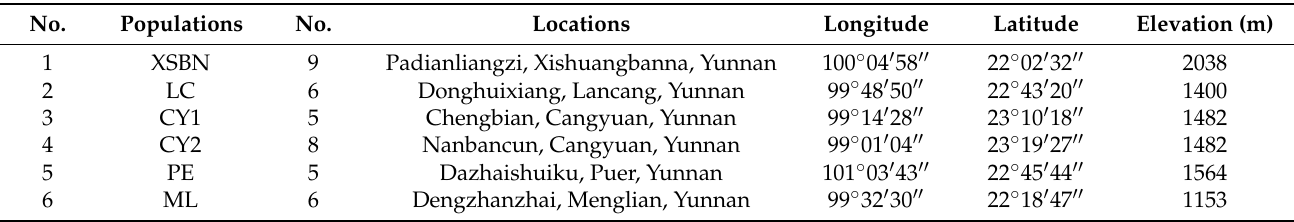
Table 1. Sample information for T. doichangensis